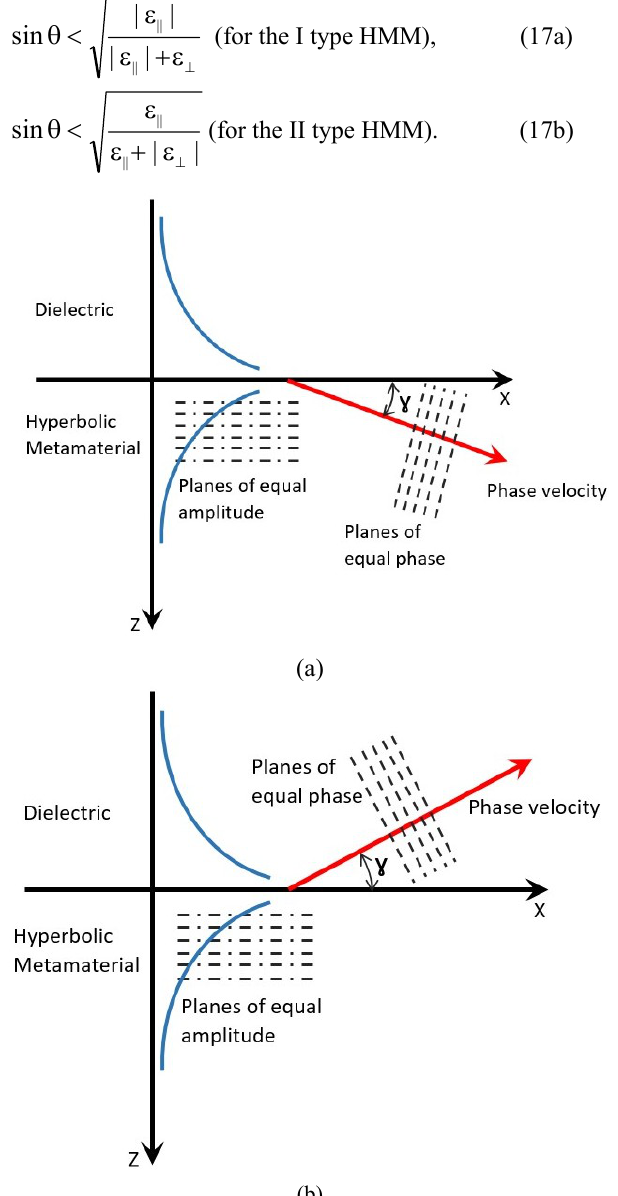
Figure 2: Orientation of the phase velocity of located wave at the boundary of hyperbolic metamaterial for the case of negative (a) and positive (b) values of the parameter d . From the boundary conditions for electric md EE , and magnetic md HH , vectors (see Eqs. (9), (10)) it follows the dispersion equation for